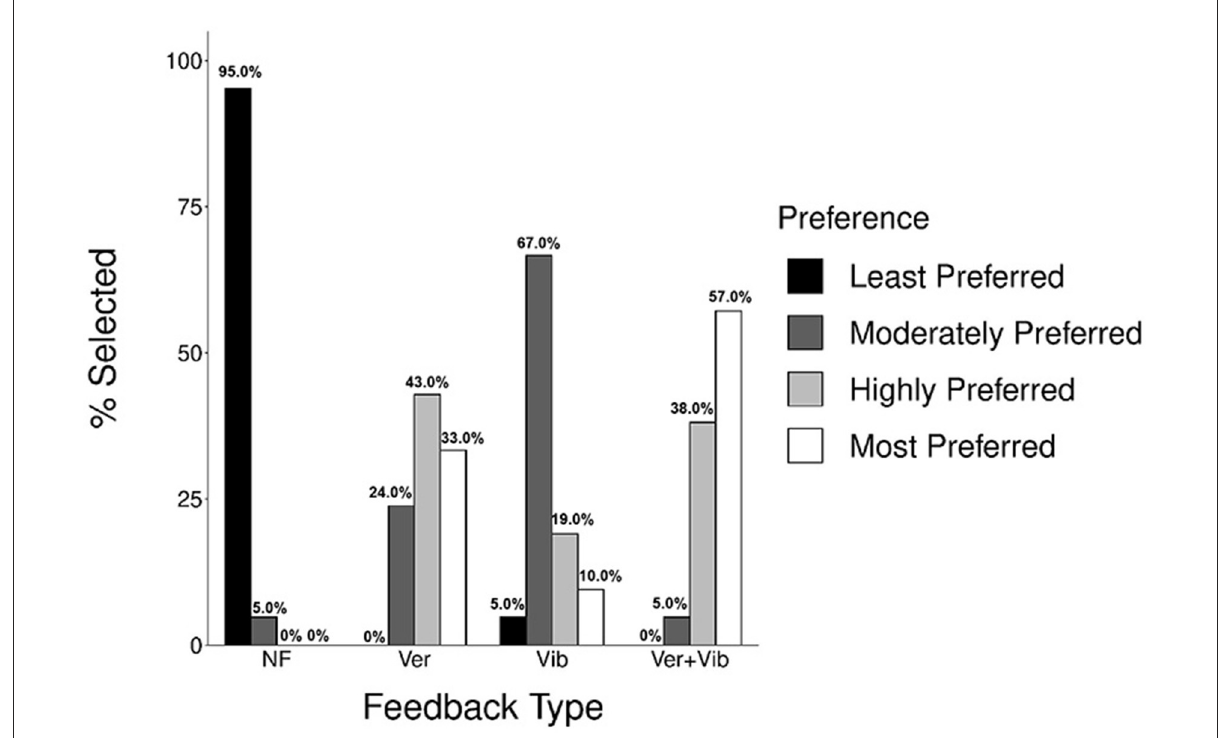
FIGURE8 Participants’ preferences for different feedback types ( n =